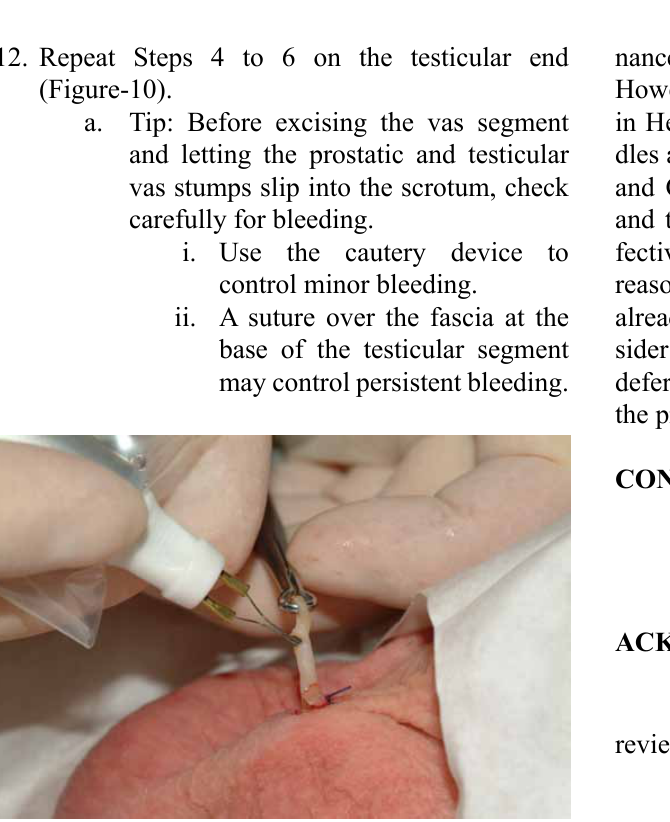
Figure 10 - Cauterizing the lumen of the testicular stump after completing FI on the prostatic